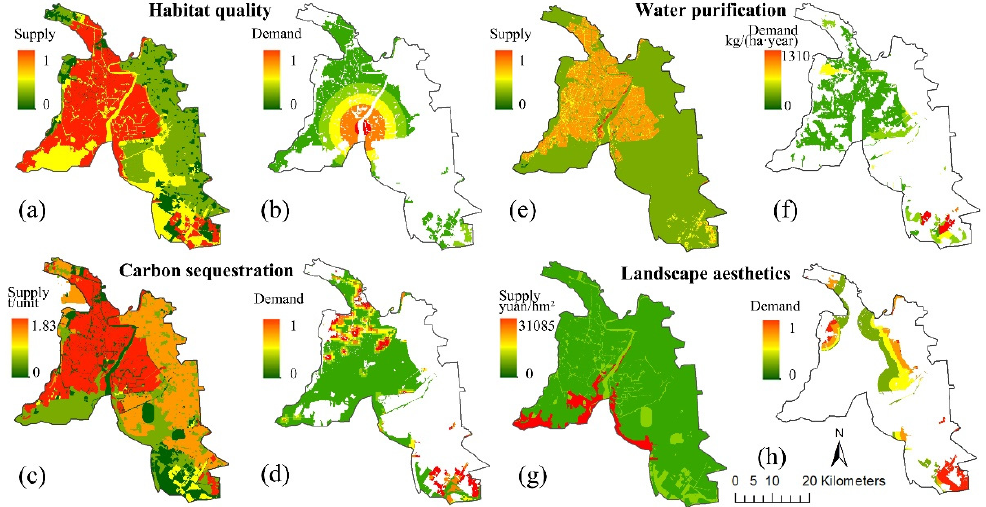
Figure 3. Natural supply potential and demand reflection of ecosystem services. ( a ), ( c ), ( e ) and ( g ) are the spatial distribution of natural supply capacity for habitat quality, carbon sequestration, water purification and landscape aesthetic services, respectively; ( b ), ( d ), ( f ) and ( h ) are reflections of the demand for habitat quality, carbon sequestration, water purification, and landscape aesthetic services in natural space,